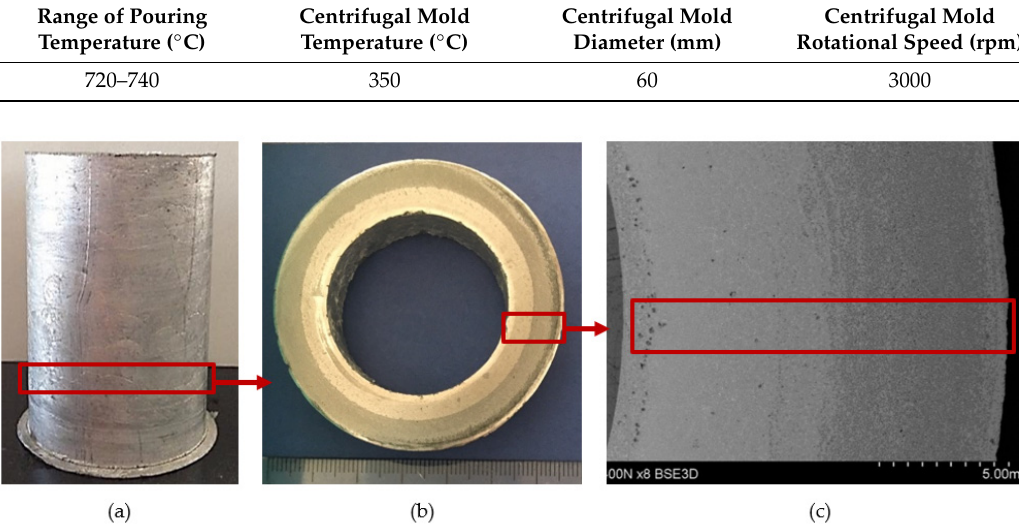
Figure 4. A centrifugal casting of a composite suspension based on AlSi12 alloy with 10% by weight share of SiC p : ( a ) a view of the casting in the form of a sleeve; ( b ) a view of ring cut out from the lower portion of the sleeve; ( c ) macrostructure of a ring fragment with reinforcement distribution visible on its cross-section. Unetched section.